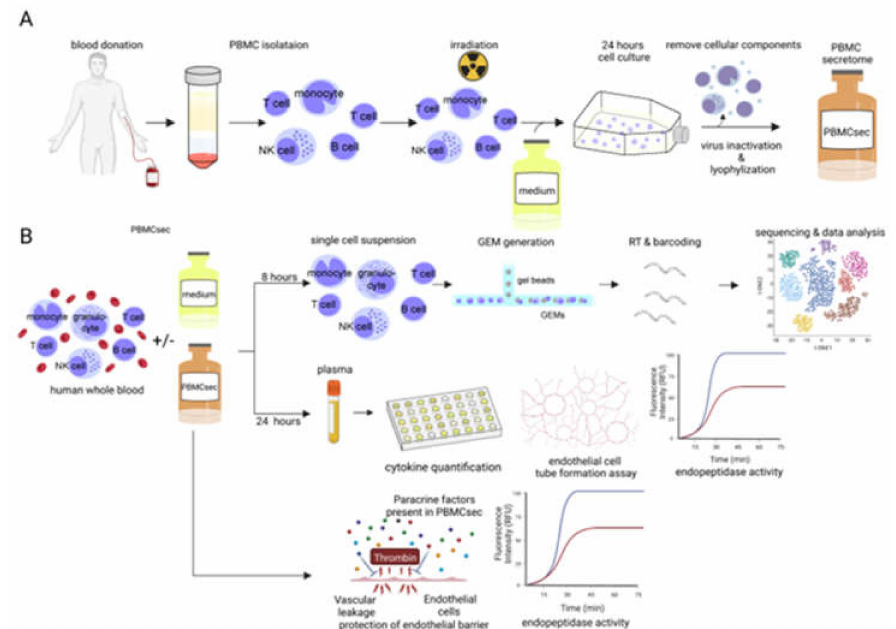
Figure 1. Experimental overview ( A ) Isolation of PBMCs from healthy donors and subsequent procedures necessary for the generation of PBMCsec. ( B ) The experimental setup involved two branches. In order to investigate pharmacodynamics effects of PBMCsec, human whole blood cells were treated with PBMCsec or left untreated for 8 h prior to further processing them for single-cell RNA sequencing. Plasma was collected from PBMCsec-treated whole blood and controls after 24 h of incubation and analyzed in a series of functional assays. In addition, we evaluated effects mediated directly by PBMCsec on endopeptidase activity and endothelial barrier protection. This figure was generated using Biorender.com (accessed on 6 June